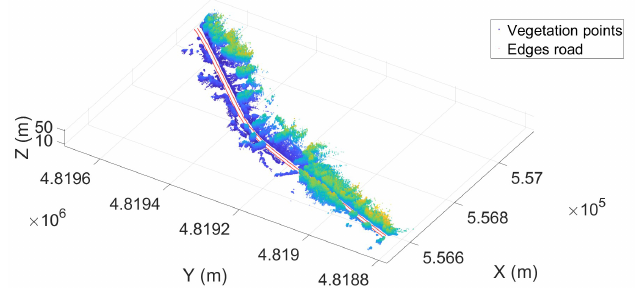
Figure 7. Vegetation points of road, limits of road are showed in red colour.